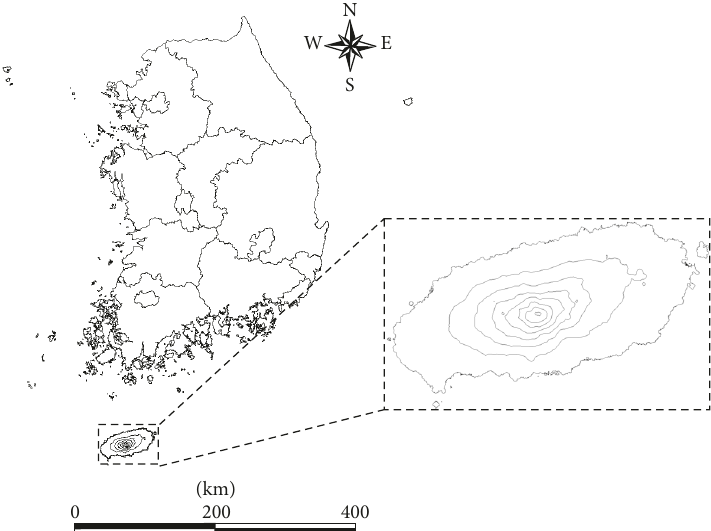
Figure 1: Location of the Jeju Island, Korea (the contour lines over the Jeju Island represent the 250 m altitude interval).